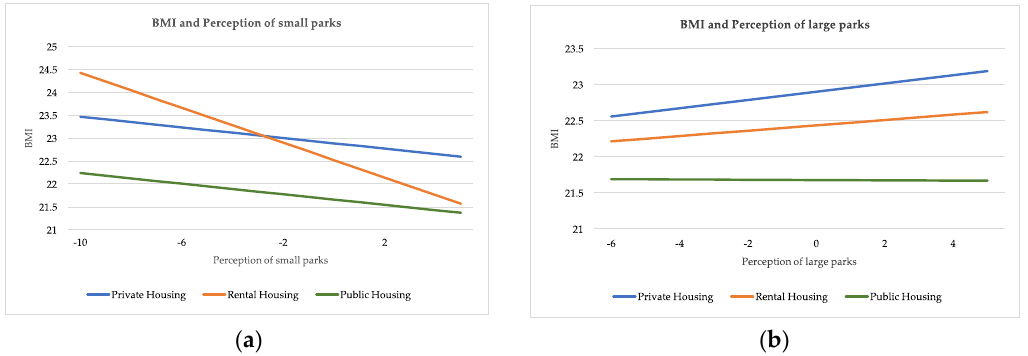
Figure 3. ( a ) Predicted relationship between individual body mass index (BMI) and the perception of small parks; ( b ) predicted relationship between individual BMI and the perception of large parks.